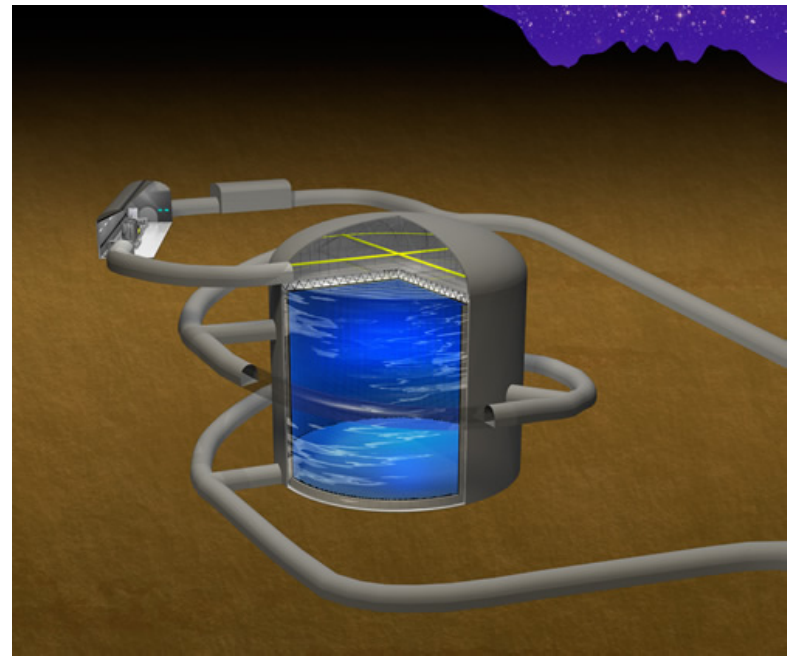
Figure 8. Layout of the Hyper-Kamiokande